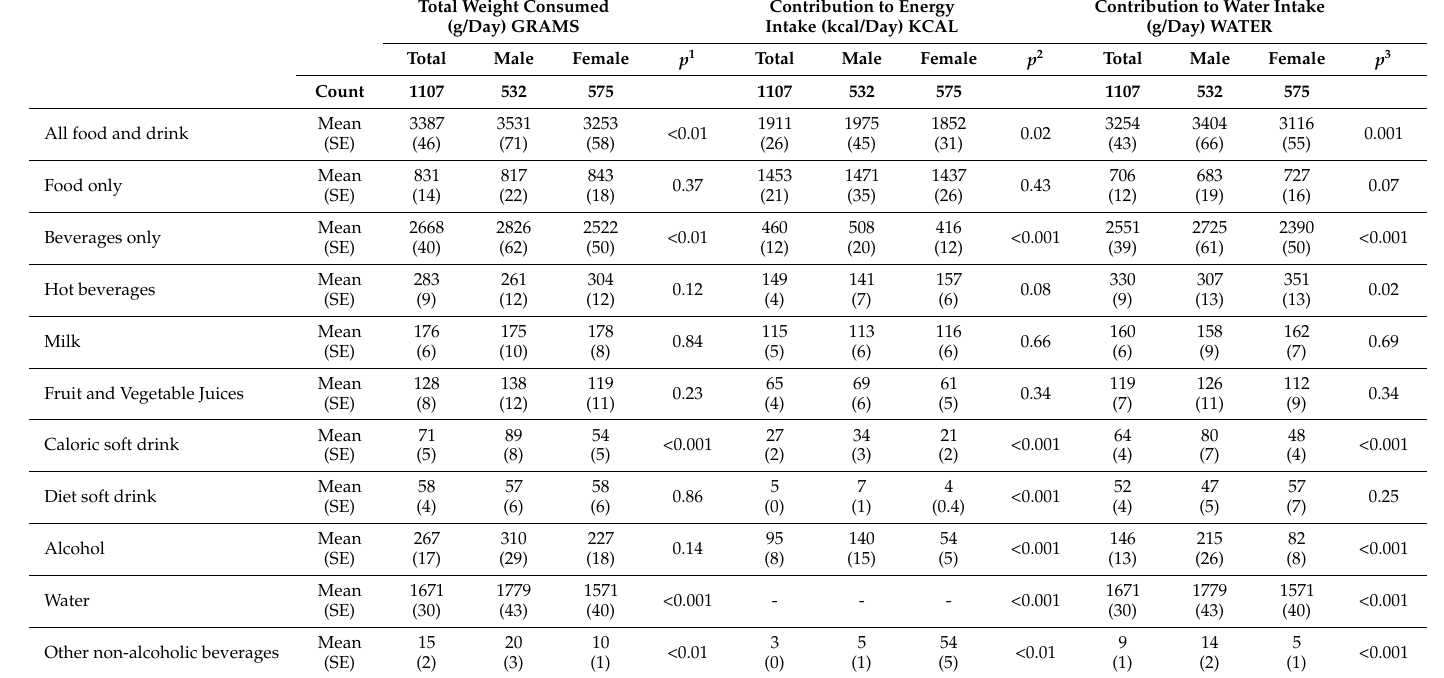
Table 2. Contribution of food and beverages to total water and energy intake of subjects using the WBQ ( n =